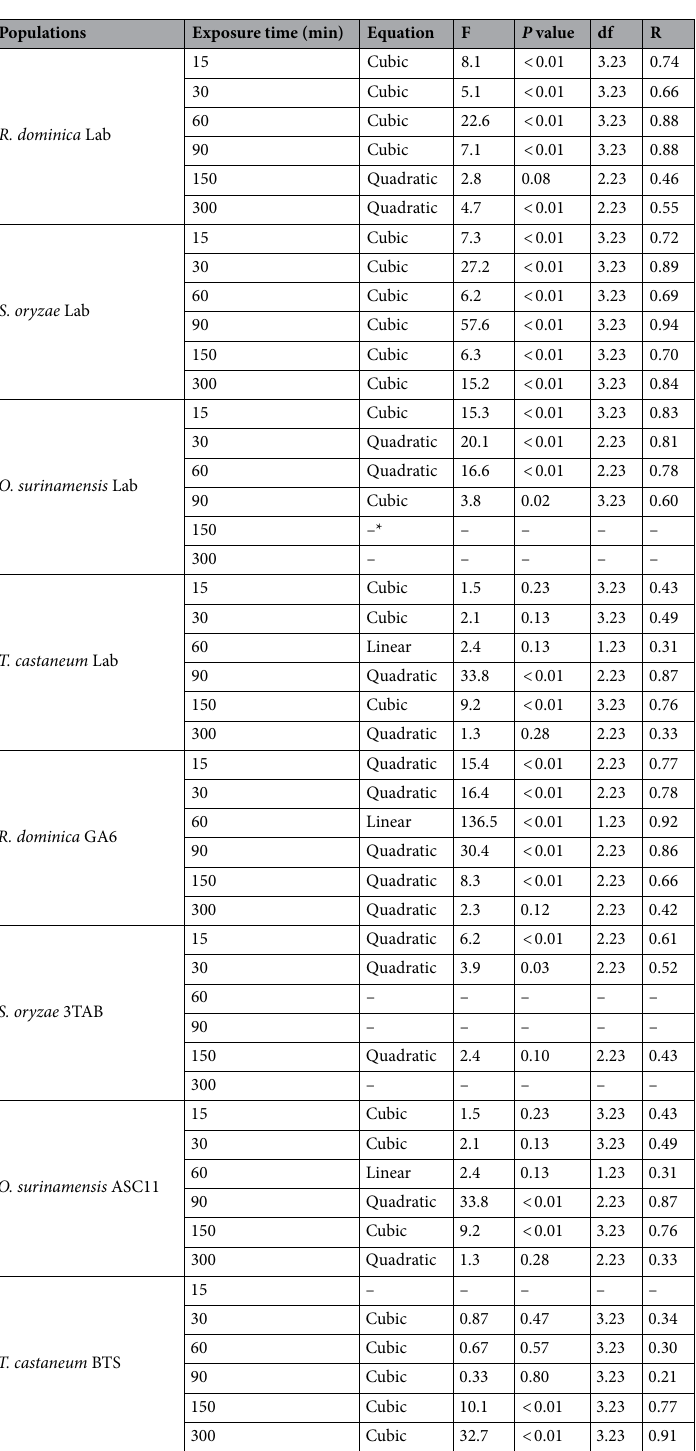
Table 2. Results of immediate effects, for curve estimations for each population tested, exposed on different exposure times (15, 30, 60, 90, 150 and 300 min) at 3000 ppm of phosphine. *Could not be estimated